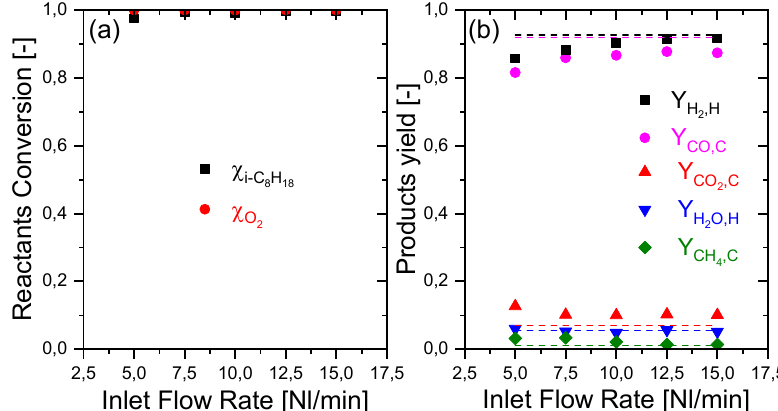
Figure 1. Effect of flow rate on the integral performance of the catalytic partial oxidation (CPO) reactor: ( a ) reactants conversion (χ); ( b ) products yield (Y i,j , i=product and j=reference atom balance). Feed composition: iC8 = 3%, air with C/O = 0.9 and N 2 complement. Symbols = experiments; dashed lines = calculated adiabatic equilibrium.